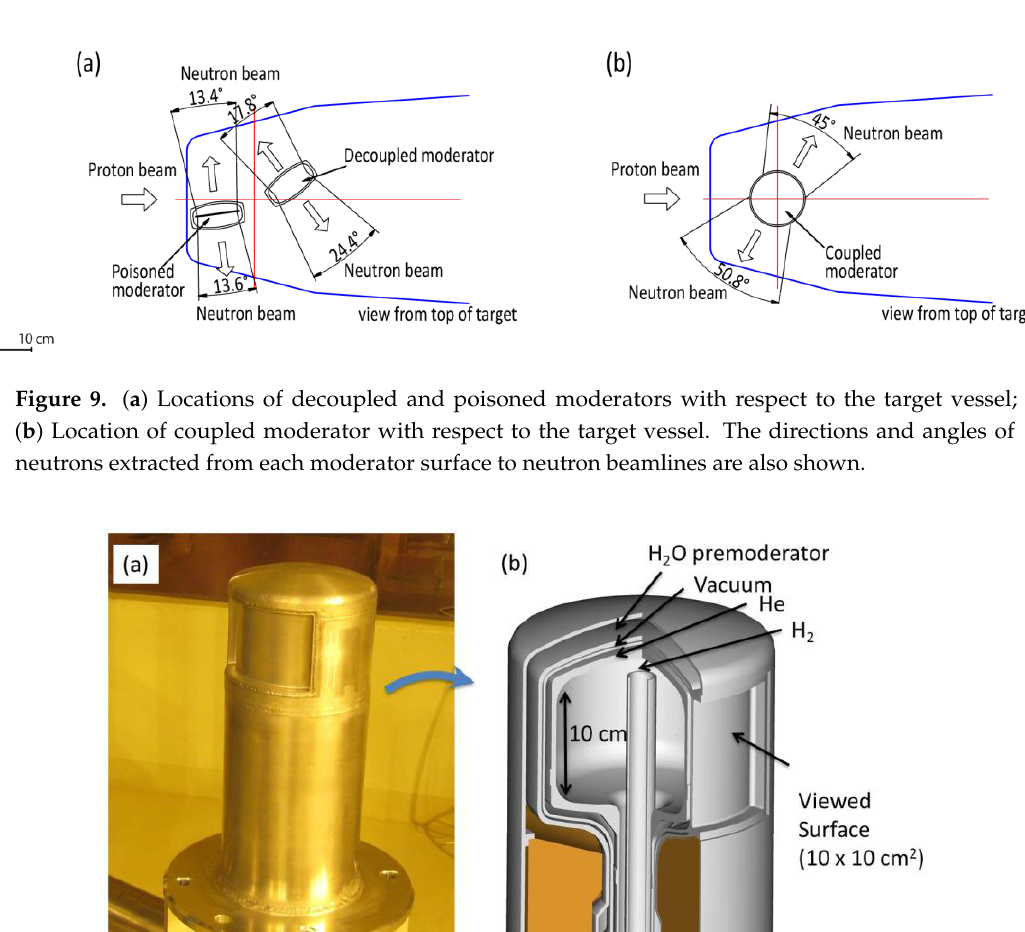
Figure 8. Cross sectional view of target-moderator-reflector.